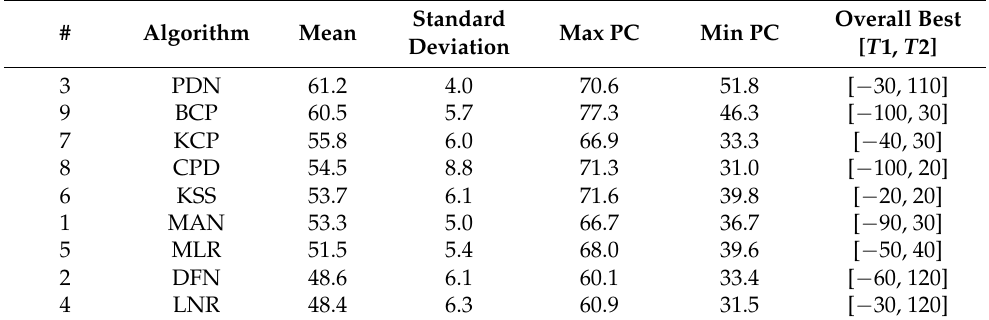
Figure 6. Heat map of the summarized PC values for all events for each algorithm (green—max PC value, red—min PC value; coloring for each heat map separately). Table 5. Mean and standard deviation, max and min PC, from heat map and overall best time